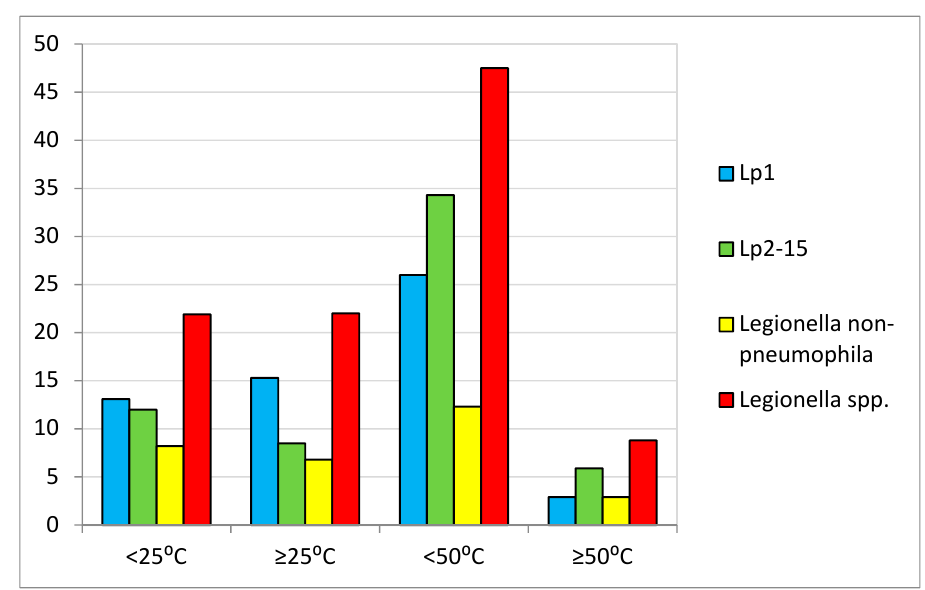
Figure 2. Samples positive for Legionella detection in temperature ranges.